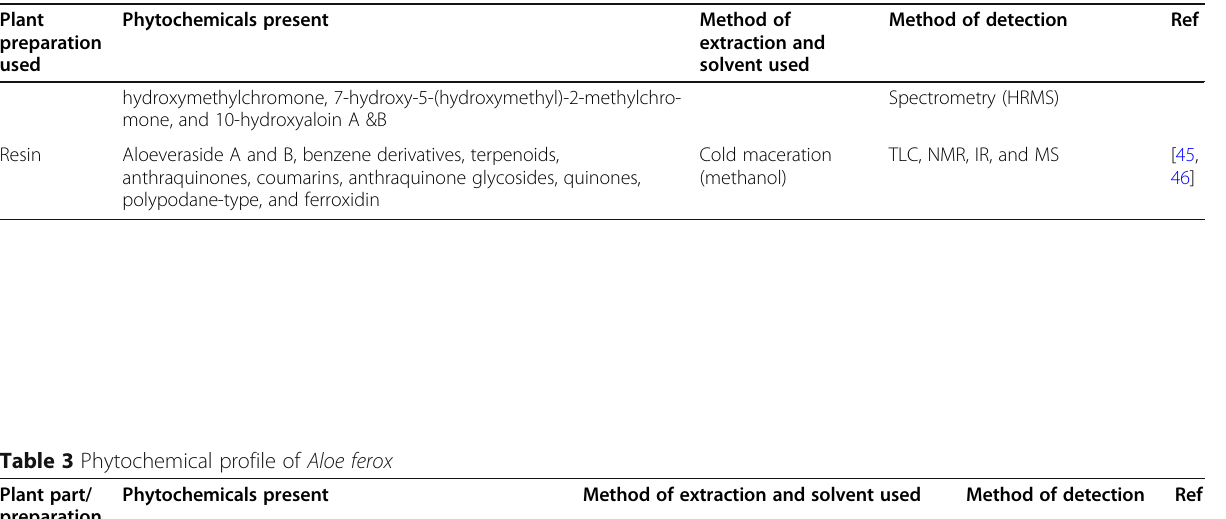
Table 3 Phytochemical profile of Aloe ferox Plant part/